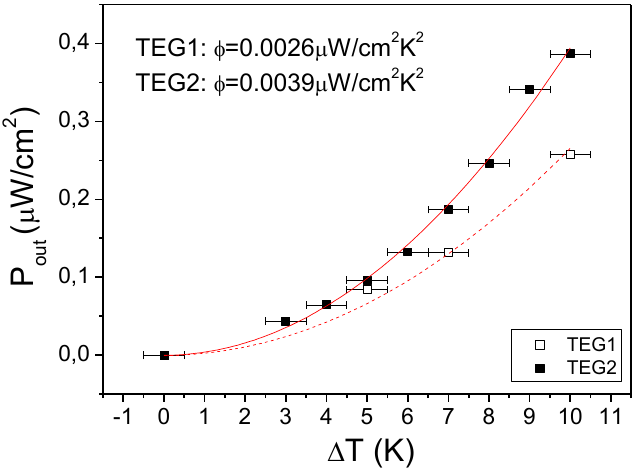
Figure 6. Output power ( P ) as a function of the macroscopic temperature difference out across the device ( ΔT ) for TEG1 and TEG2. The red lines represent parabolic fits to the experimental